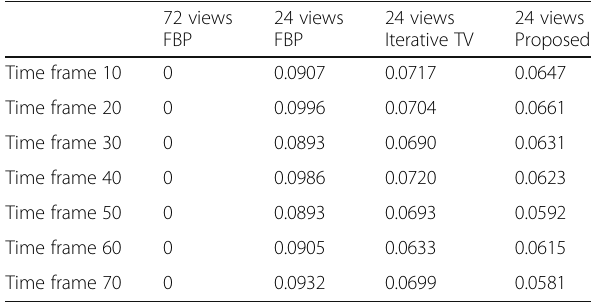
Table 2 RMSE for various reconstruction methods 72 views